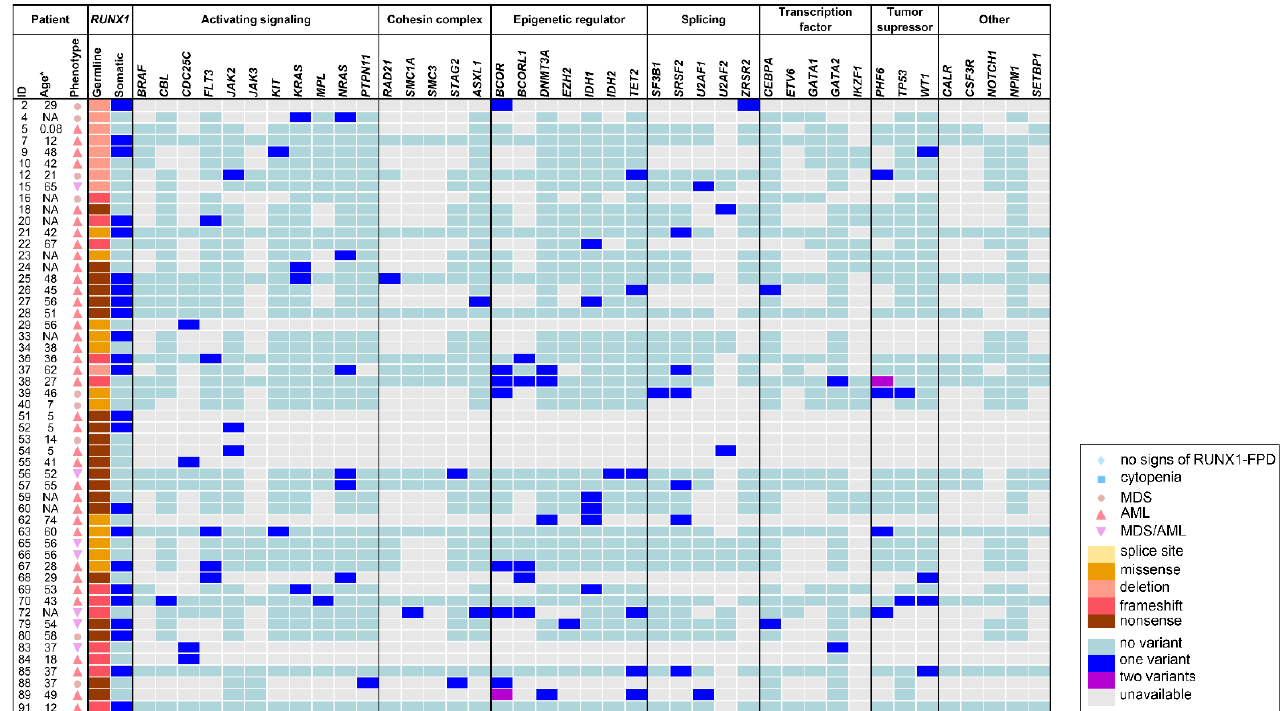
Figure 4. Frequently investigated and affected genes within the subgroups MDS, AML, and. MDS/AML. Illustration of age, phenotype, type of RUNX1 germline variant and analyzed somatic variants for 53 HM cases with MDS and/or AML. For references to the individual patients please MDS—myelodysplastic syndrome, MDS/AML—patients who developed MDS and subsequently AML, NA—not available, RUNX1-FPD—familial platelet disorder with predisposition to